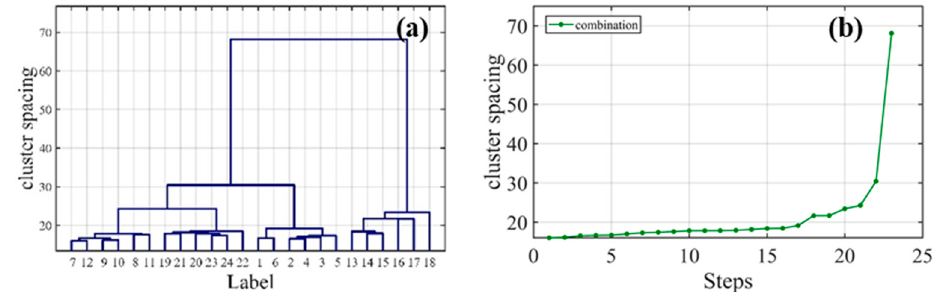
Figure 6. Training set hierarchical clustering tree and cluster distance line diagram. ( a ) Stokes and DOLP combination data set hierarchical cluster tree ( b ) Data combination layer cluster distance folding line change diagram .